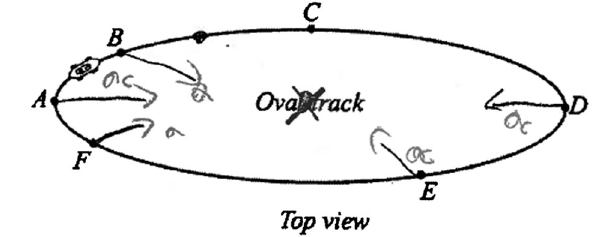
FIG. 1. Felix ’ s written work for the oval track prompt during the first interview.